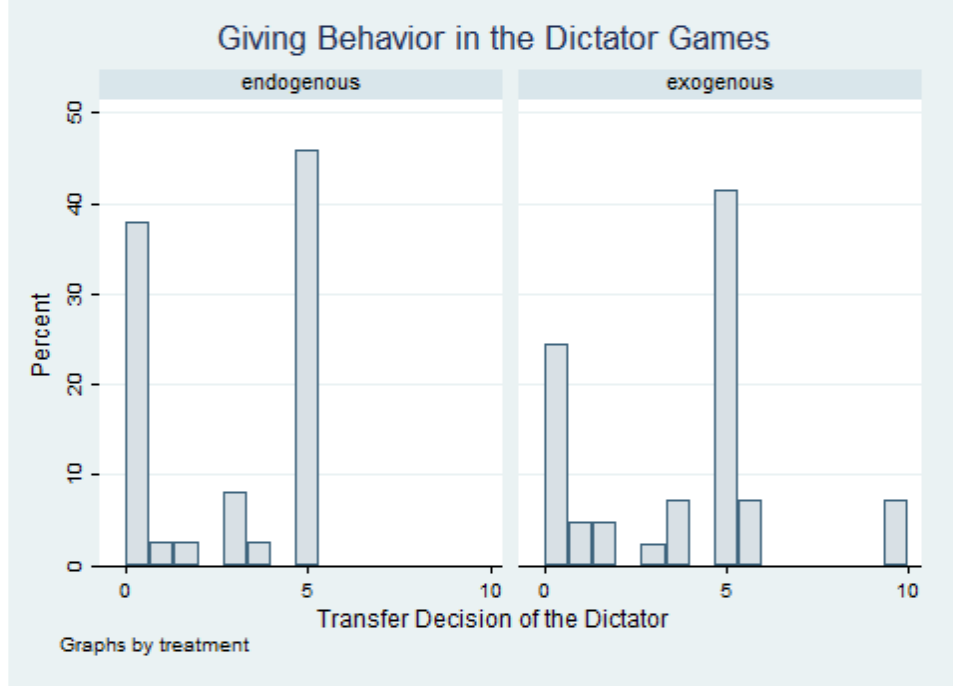
Figure 1. Giving behavior in exogenous and endogenous dictator games.